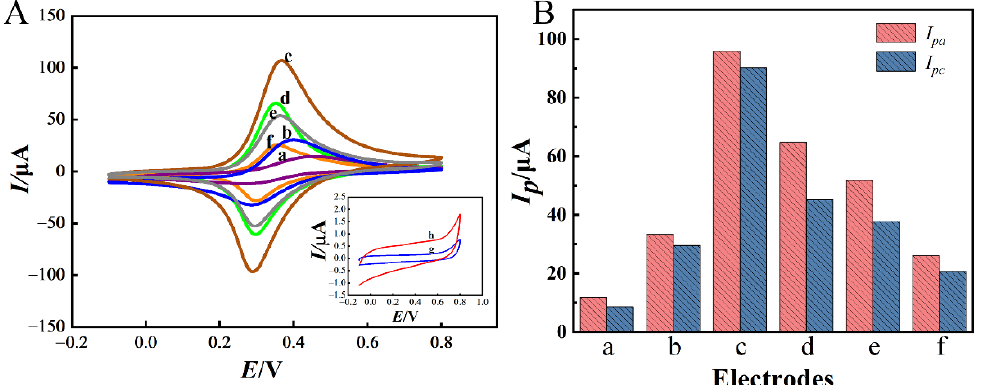
Figure 6. CV curves of different modified GCEs in 0.1 M PBS (pH = 7.0) ( A ) and the peak current values for different modified GCEs ( B ). a: NiHCF-NPs/GCE, b: NiHCF-NPs/Zn/Fe-ZIF-NPC/GCE, c: AuNPs/NiHCF-NPs/Zn/Fe-ZIF-NPC/GCE, d: Apt/AuNPs/NiHCF-NPs/Zn/Fe-ZIF-NPC/GCE, e: ZIF-NPC/GCE, g: bare GCE, h: MCH/Apt/AuNPs/Zn/Fe-ZIF-NPC/GCE. The modification condi- tions are the same as in Figure 4.